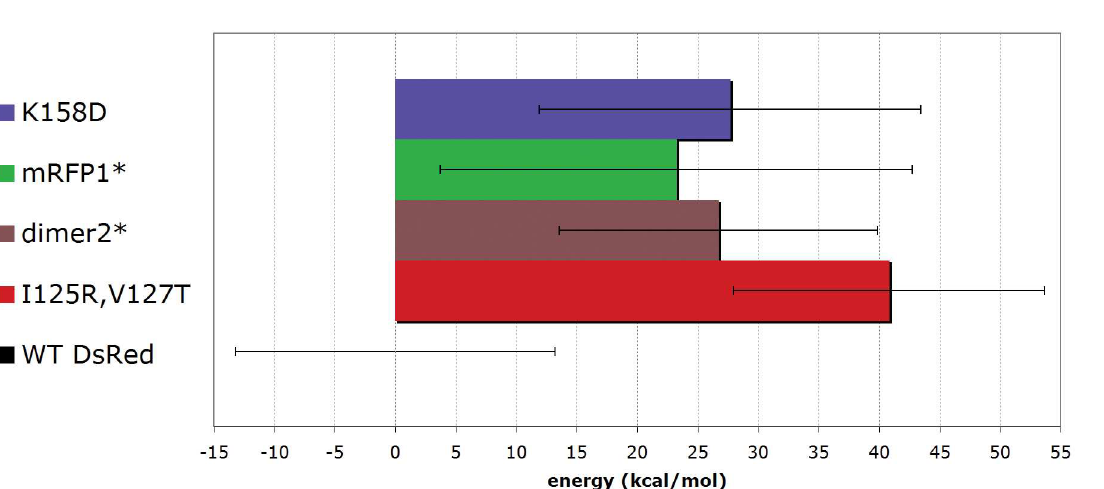
Figure 4. MMPBSA-estimated ∆∆ G s with respect to WT DsRed. Structures for all mutants were generated from crystal structure of this latter (1GGX PDB code). For dimer2* (T21S, H41T, C117T, I125R, V127T and S131P) and mRFP1*(T21S, H41T, C117E, I125R, V127T, R153E, V156A, H162K, A164R, L174D, I180T, Y192A, Y194K, H222S, L223T, F224G, L225A), only experimentally validated mutations according to [27] corresponding to solvent exposed residues were